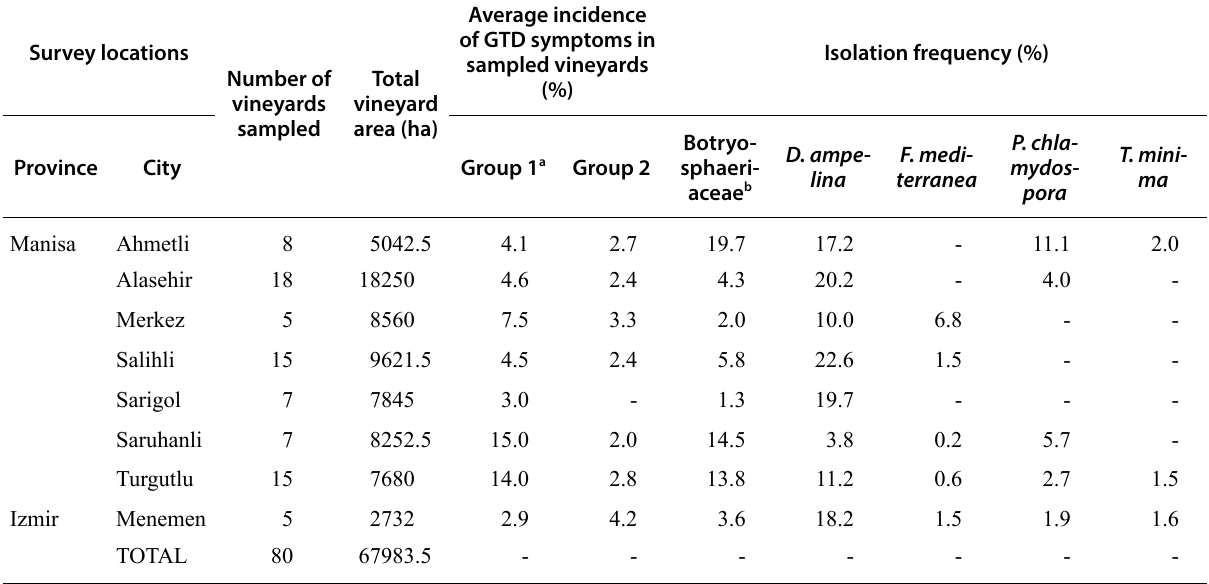
Table 1. Information regarding vineyards sampled, average incidence of disease symptoms and fungal isolation frequency by grape growing province and cities in Turkey. Survey